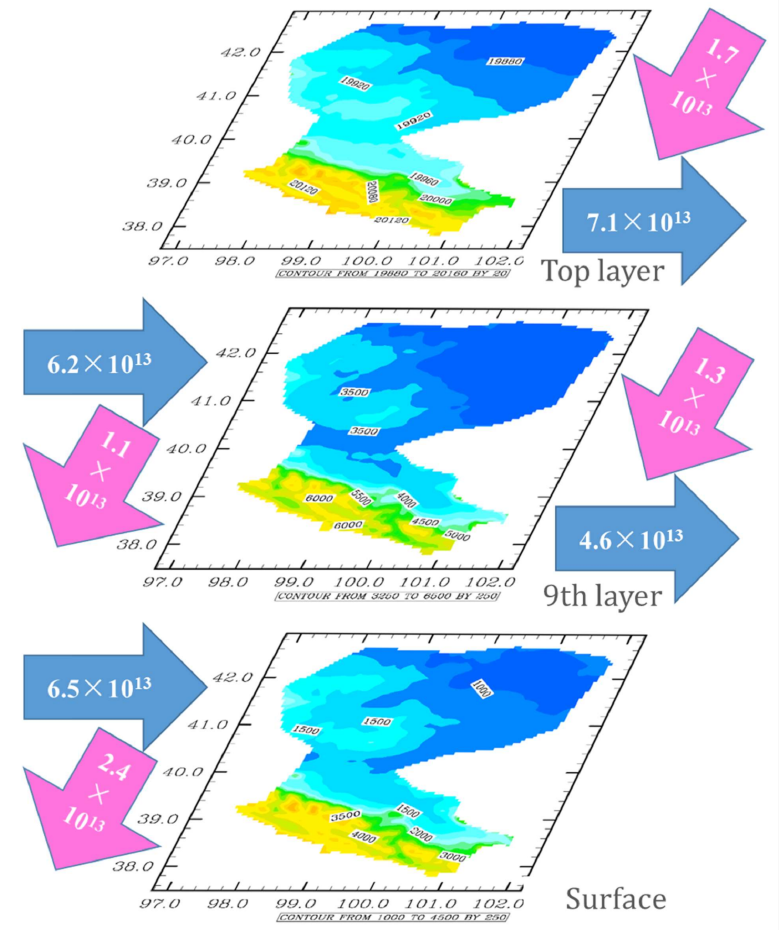
Figure 4. The net water vapor transport in the X and Y directions (kg/year). The blue arrow represents the water vapor transported by west wind, and the pink arrow represents the water vapor transported by north